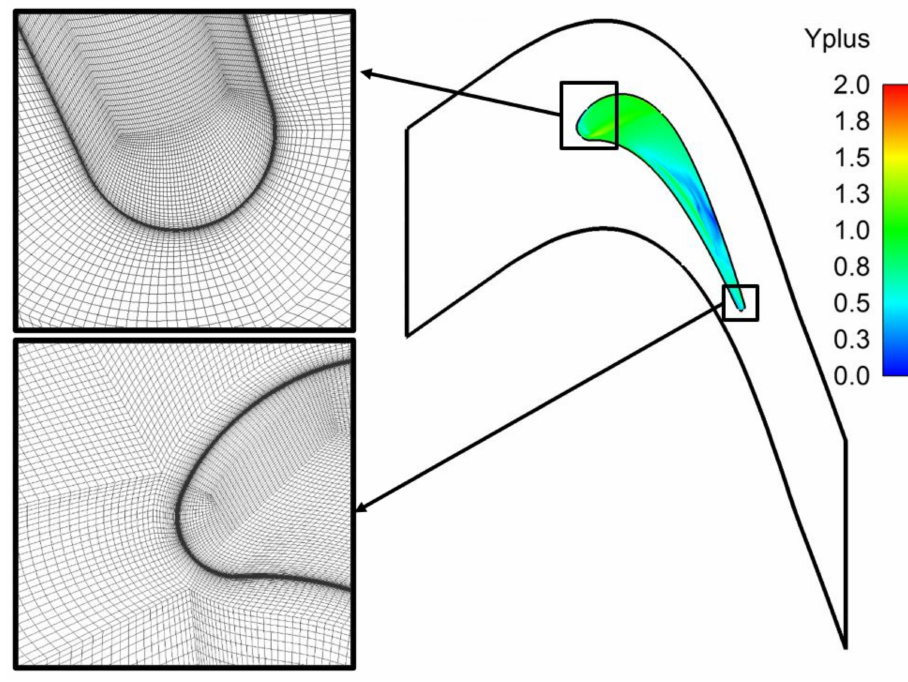
Figure 2. Computational domain and mesh information with tip y+ distribution.